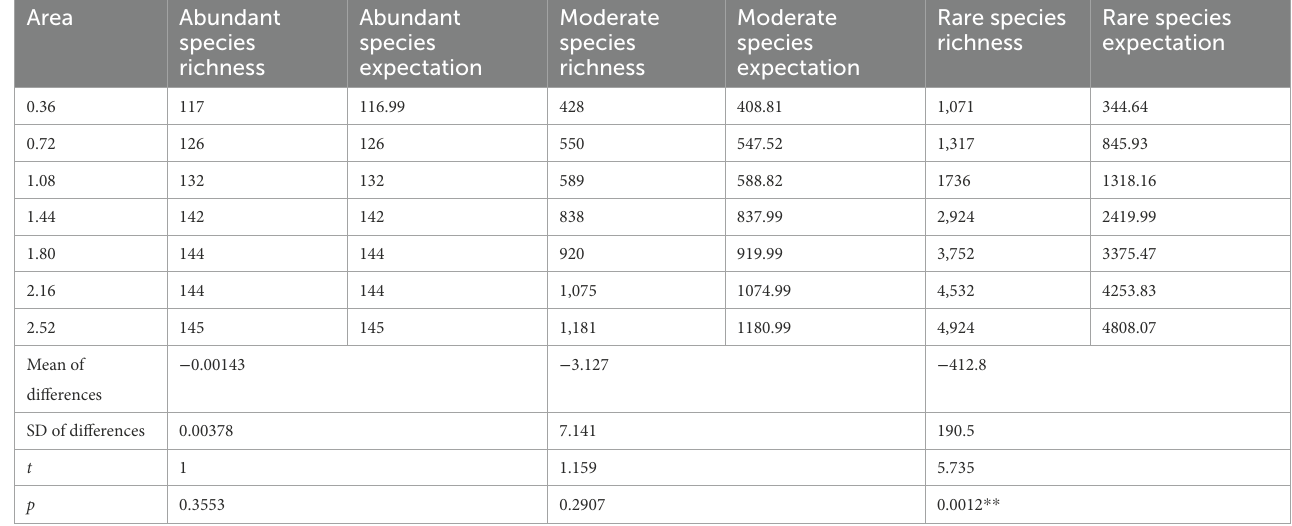
TABLE 2 Differences between species richness predicted by Coleman’s random sampling model and actual observed richness.